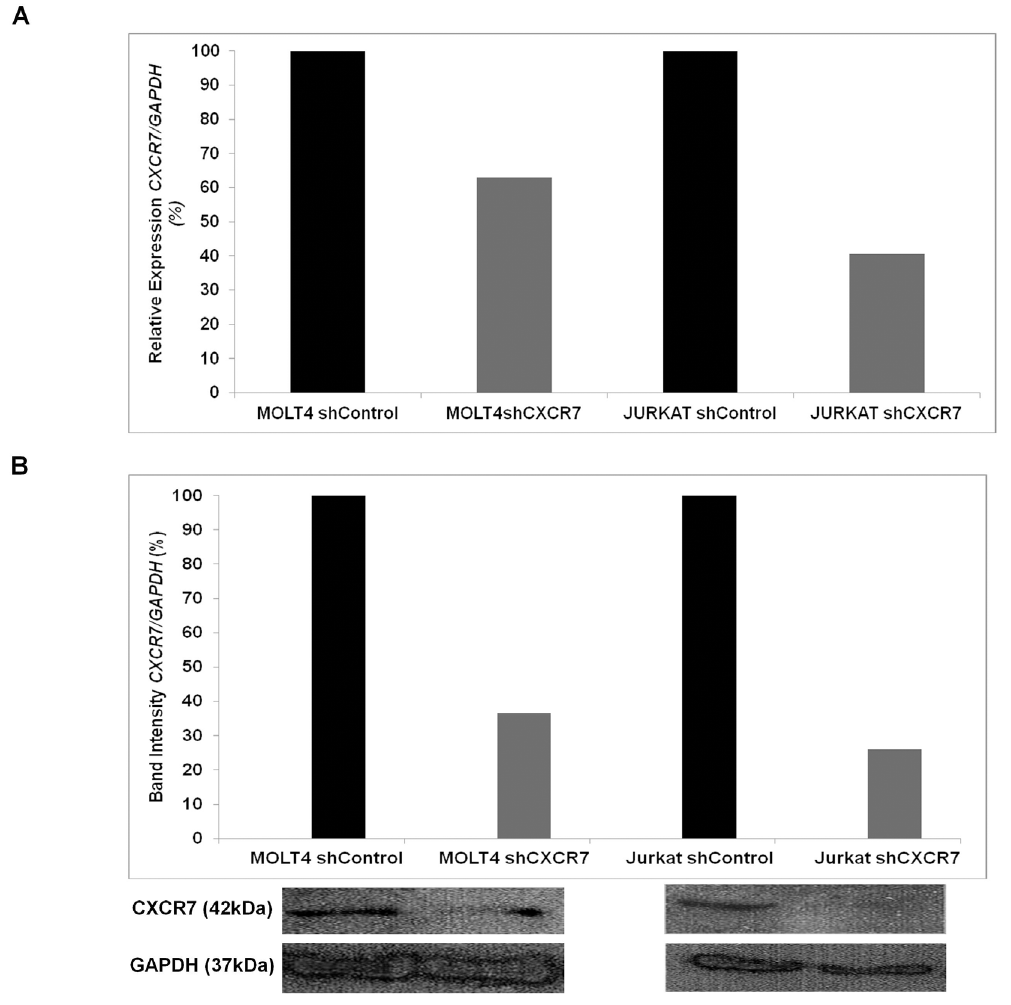
Figure 6. Lentivirus-mediated shRNA targeting CXCR7 effectively silenced CXCR7 in MOLT4 and Jurkat cells. A) Quantitative expression of CXCR7 mRNA in cells relative to the shControl cells. mRNA expression levels of CXCR7 were normalized by HPRT and GAPDH endogenous control. Results were analyzed using 2 2 DD CT . CXCR7 mRNA expression was reduced in MOLT4 cells (41%) and Jurkat cells (63%) when compared with shControl cells. (B) Western blotting analysis of shControl and shCXCR7 cell extracts. The membrane was blotted with antibodies against CXCR7 (42 kDa) or GAPDH (37 kDa), as a control for equal sample loading, and developed with the ECL Western Blot Analysis System. The bar graphs represent the band intensity of CXCR7 protein expression corrected for loading differences based on the corresponding GAPDH bands (UN-SCAN-IT software). Protein levels of CXCR7 were also reduced in MOLT4 cells (63%) and Jurkat cells (74%) when compared with shControl cells.